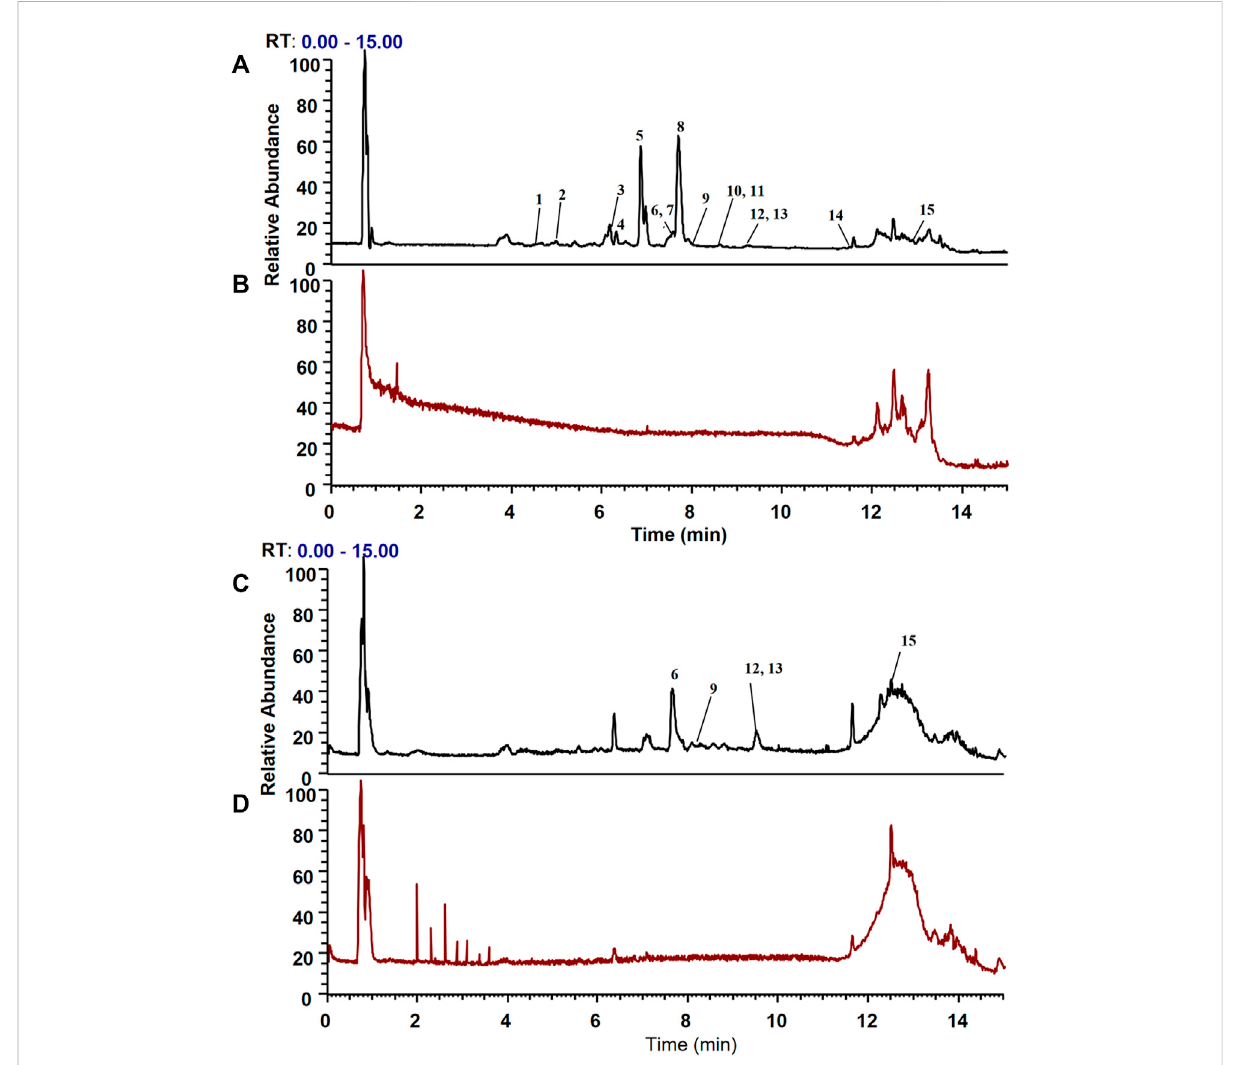
FIGURE 4 Total ion chromatograms of the dissociated solutions of the Huanglian Jiedu decoction (HLJDD) treatment and control groups in positive and negative modes. The dissociated components in the solution were identi fi ed using the UPLC-Orbitrap Fusion Tribrid MS system, and 15 different components were identi fi ed in the solution of the HLJDD-treated group compared with the control group in positive and negative ion modes. (A) Positive ionmodeoftheHLJDDgroup; (B) positive ionmodeofthecontrol group; (C) negativeion modeoftheHLJDDgroup; (D) negativeion mode of the control